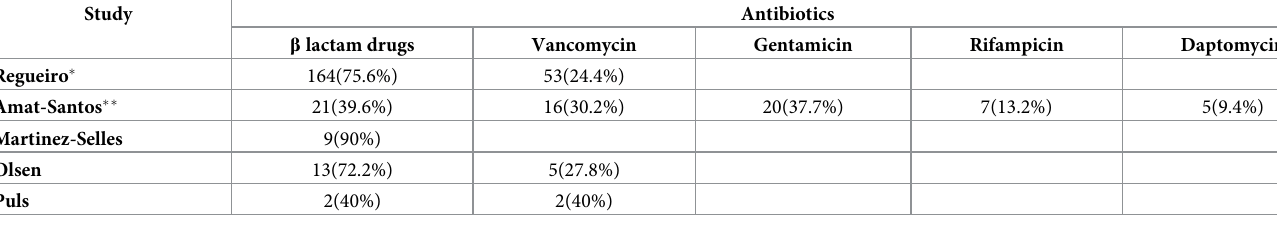
Table 6. Antibiotics used for treatment of post-TAVI IE in 5 studies.